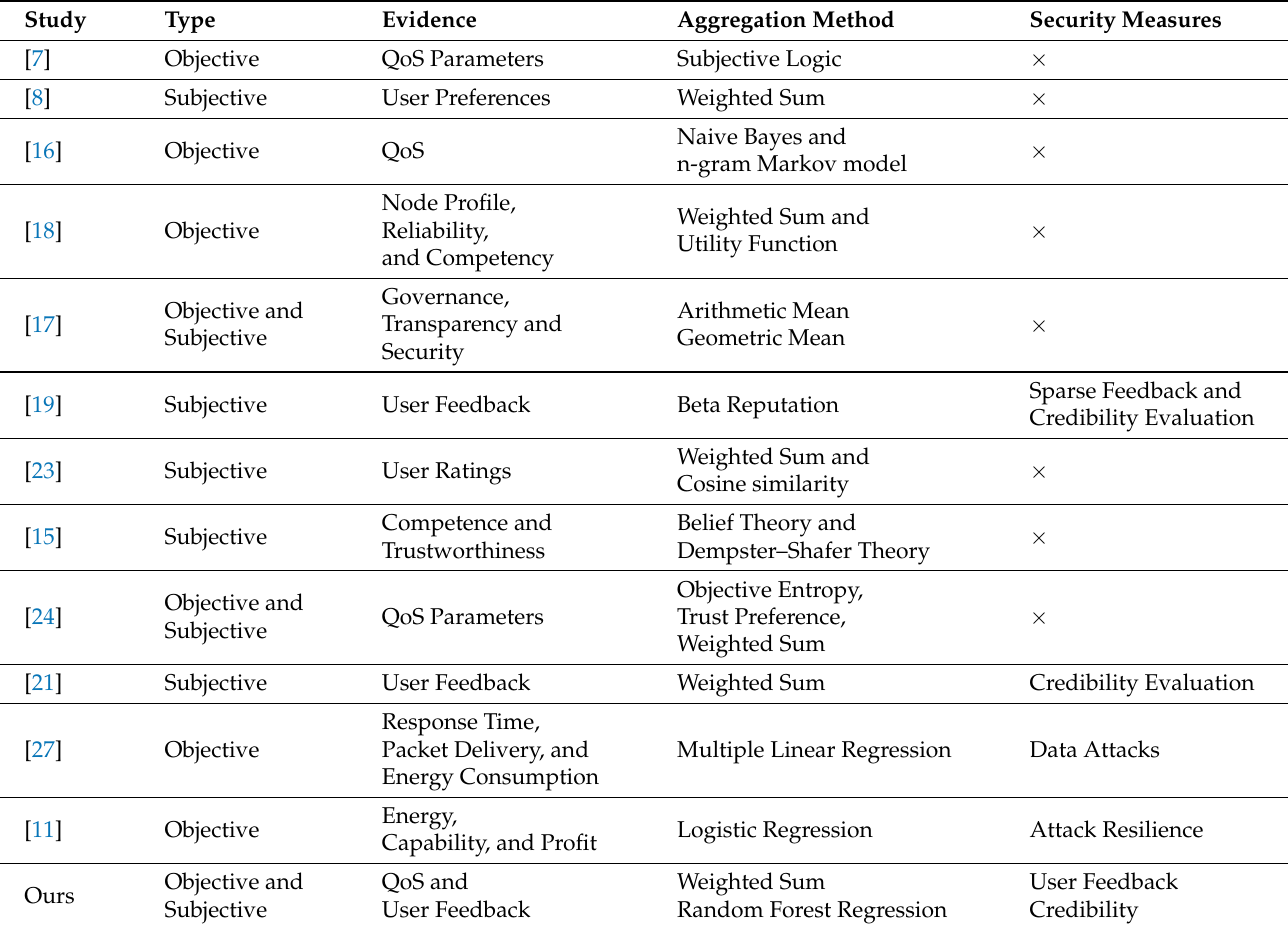
Table 1. State-of-the-Art Trust